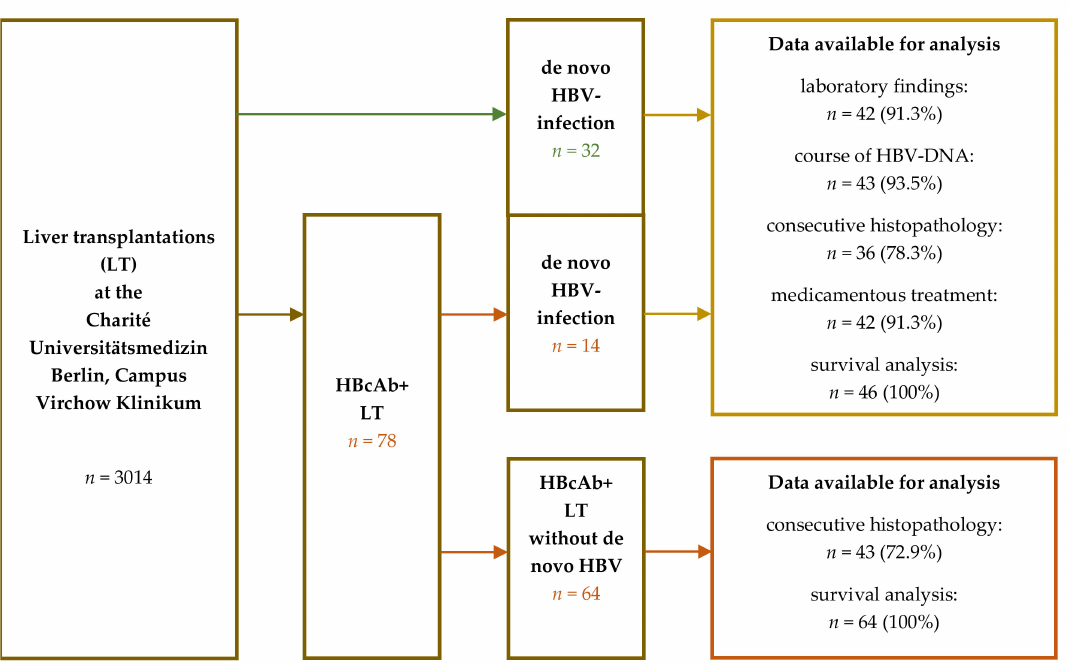
Figure 1. Patient collectives. From 1988 to 2017, n = 2686 patients underwent 3014 liver transplantations (LT) for various liver diseases. Among these, n = 46 patients that were successfully transplanted were reported with hepatitis B-Virus (HBV)-infection after LT without prior known infection. n = 14 of this group had received an hepatitis B core antibody (HBcAb)+ graft forming a collective of n = 78 successfully transplanted patients with HBcAb+ LT and without prior